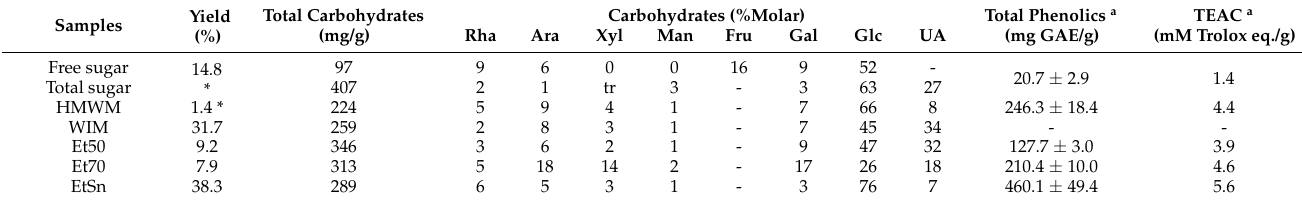
Table 3. Carbohydrate composition, total phenolic content, and Trolox equivalent antioxidant capacity from lemongrass nondistilled aqueous phase (free sugars and total sugars), HMWM lemongrass, and fractions (WIM, Et50, Et70, and EtSn) obtained after ethanol precipitation of HMWM. Samples